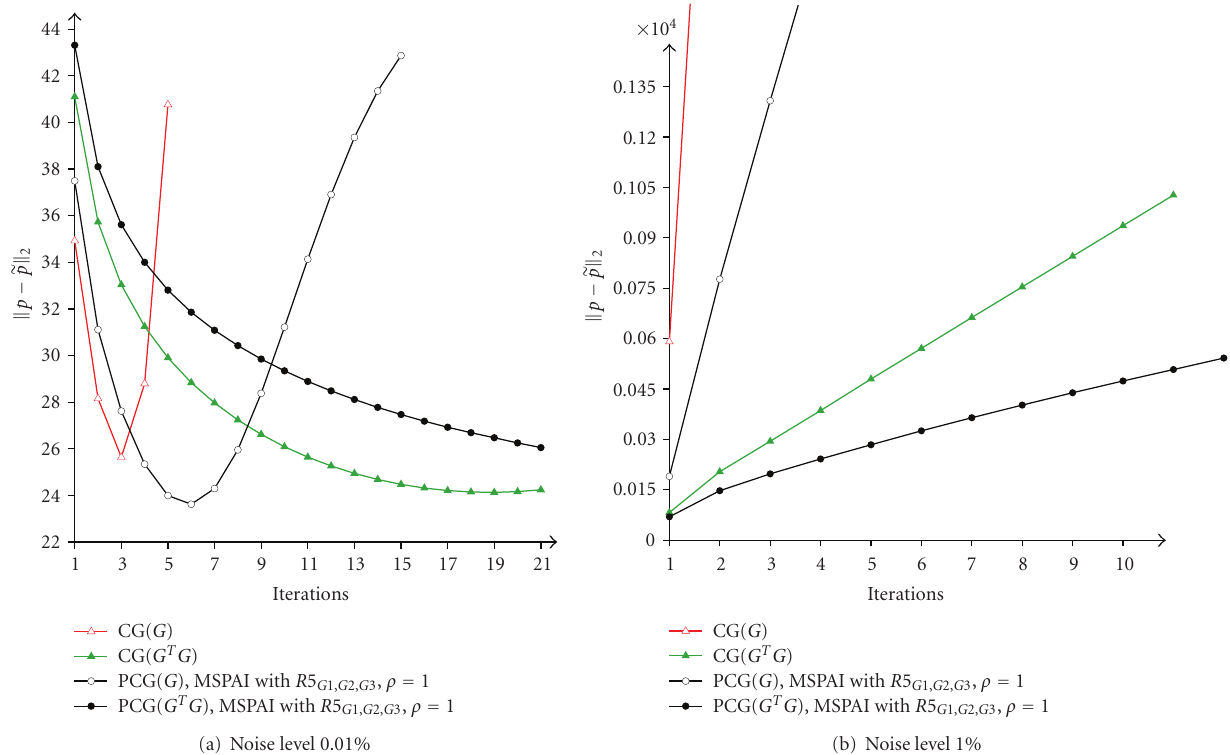
Figure 8: Reconstruction error against the iteration for the noise of order 0.01% (a) and 1% (b), respectively. CG is compared to CG using normal equations, PCG using MSPAI with R 5 G 1 , R 5 G 2 , R 5 G 3 , and PCG using MSPAI for normal equations with ρ = 1. We use M + M T as preconditioner within PCG( G ) and M T M for PCG( G T G